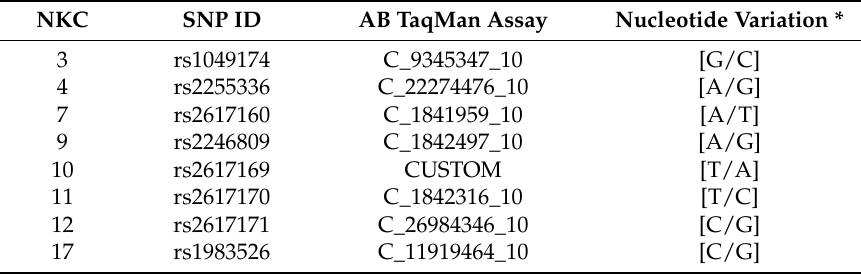
Table 8. TaqMan assays used for SNP typing of the NKC